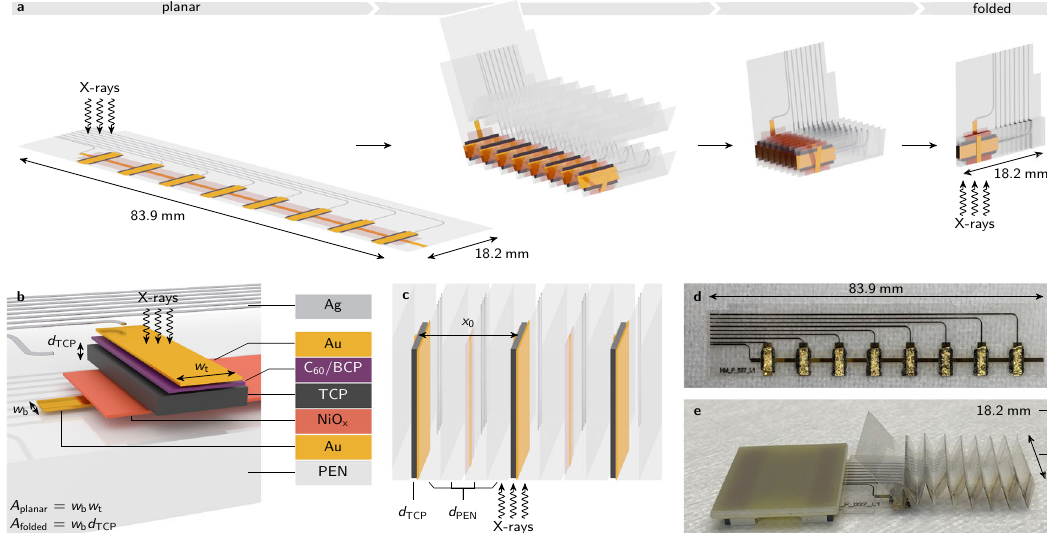
Fig. 1 Planar and origami-inspired folded X-ray detector. a Illustration of the folding process and the design of the perovskite X-ray detector in the planar and in the folded con fi guration. The respective orientation of the impinging X-ray radiation is additionally indicated. b Layer stack illustrated by an exemplary pixel in the planar con fi guration. A 25- μ m-thick polyethylene naphthalate (PEN) foil serves as fl exible substrate. Each pixel comprises thermally evaporated gold electrodes, a sputtered NiO x hole transport layer, a 6- μ m-thick inkjet-printed triple cation perovskite (TCP) absorber, and a thermally evaporated C 60 fullerene and bathocuproine (BCP) electron transport layer. Aerosoljet- printed silver lines connect the pixel electrodes to the external read out electronics. The width of the bottom and top electrodes w b and w t , the thickness of the TCP absorber d TCP , and the calculation of the effective pixel areas in the planar A planar and in the folded con fi guration A folded are additionally indicated. With a TCP absorber thickness of d TCP = 6 μ m and mean electrode widths of w b ¼ 1 : 02 mm and w t ¼ 2 : 17 mm , the mean effective pixel areas can be estimated as A planar ¼ 2 : 21mm 2 and A folded ¼ 6 : 12 ´ 10 (cid:2) 3 mm 2 . c Section out of an exemplary pixel in the folded con fi guration. A second PEN foil serves as an additional protection layer. The dimensions of the TCP absorber d TCP , the substrate d PEN , and the pixel pitch of the folded detector x 0 are additionally indicated. The respective orientation of the X-ray beam in the planar ( b ) and in the folded con fi guration ( c ) emphasizes the reorientation of the TCP absorber within the X-ray beam by the